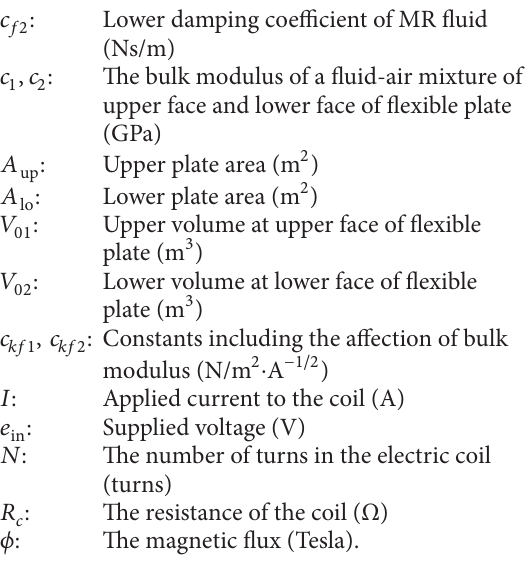
The dynamic yield stress of radial fluid Factor of the flow velocity profile